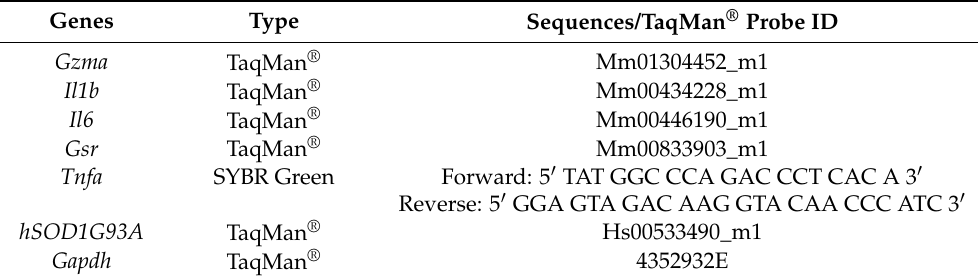
Table 2. TaqMan ® probes and primer sequences used for qPCR analysis. Genes